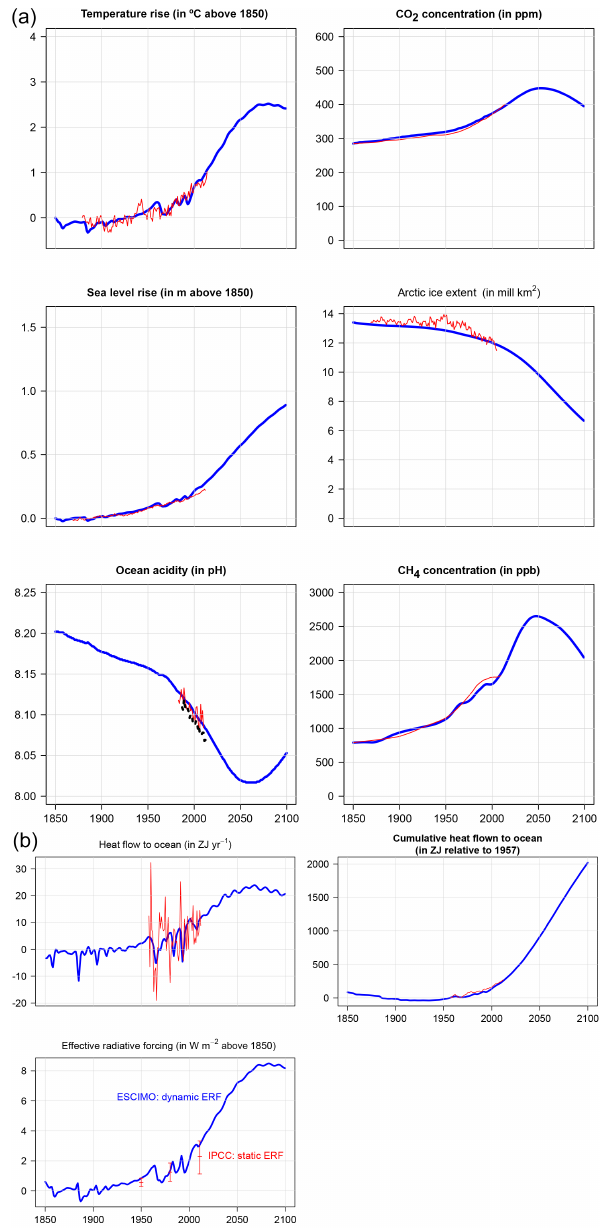
Figure 5. ESCIMO base run (blue) compared to history (red). World 1850 to